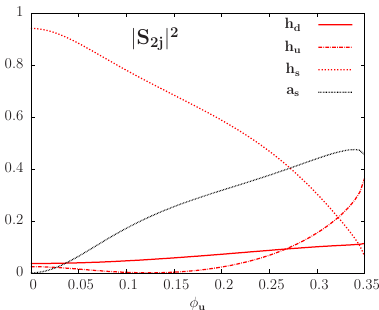
Figure 9. The decomposition of the heavier Higgs state H 2 in terms of the Higgs electroweak eigenstates as a function of the phase φ u